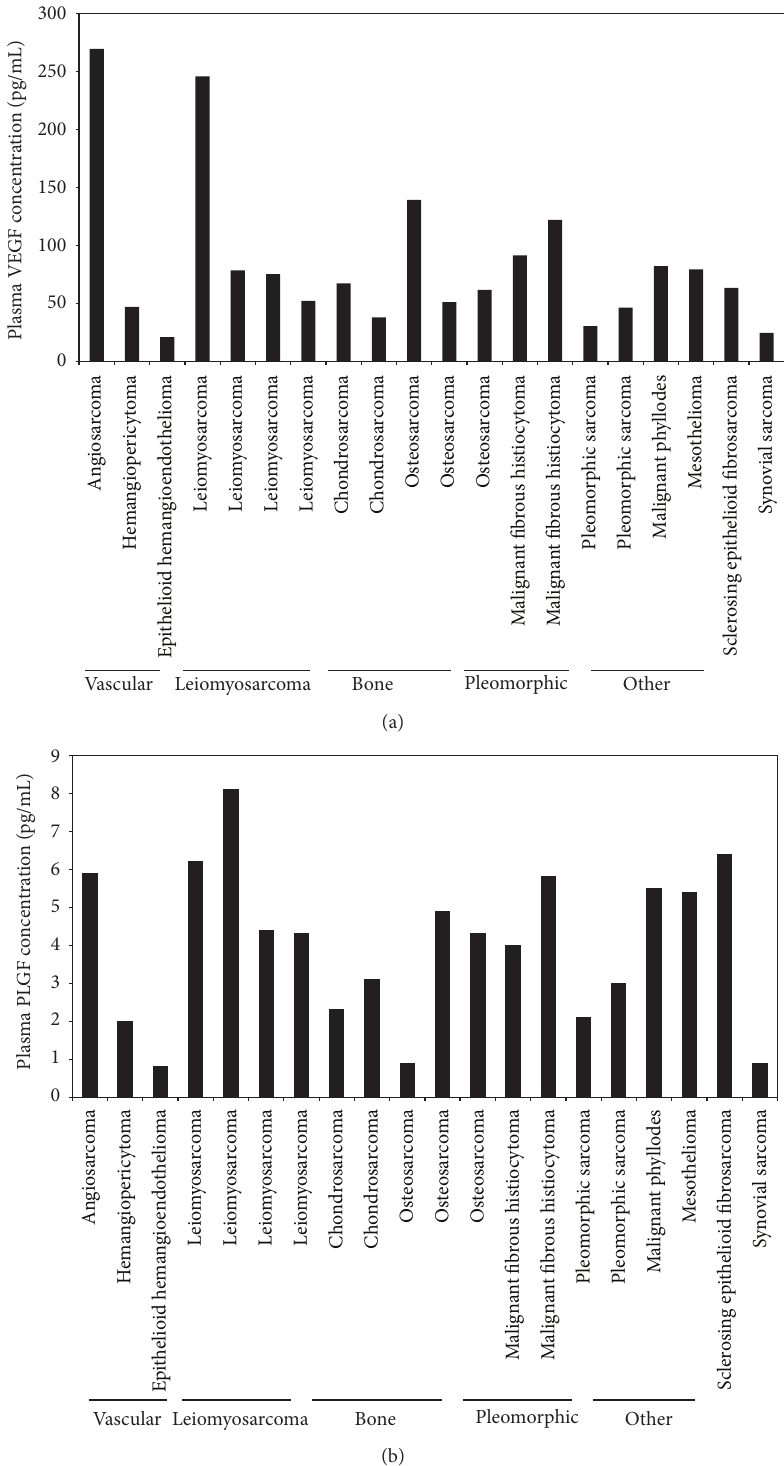
Figure 2: Pretreatment plasma concentrations of VEGF (a) and PlGF (b) are shown according to sarcoma subtype. Pretreatment VEGF concentrations were highest in the patient with